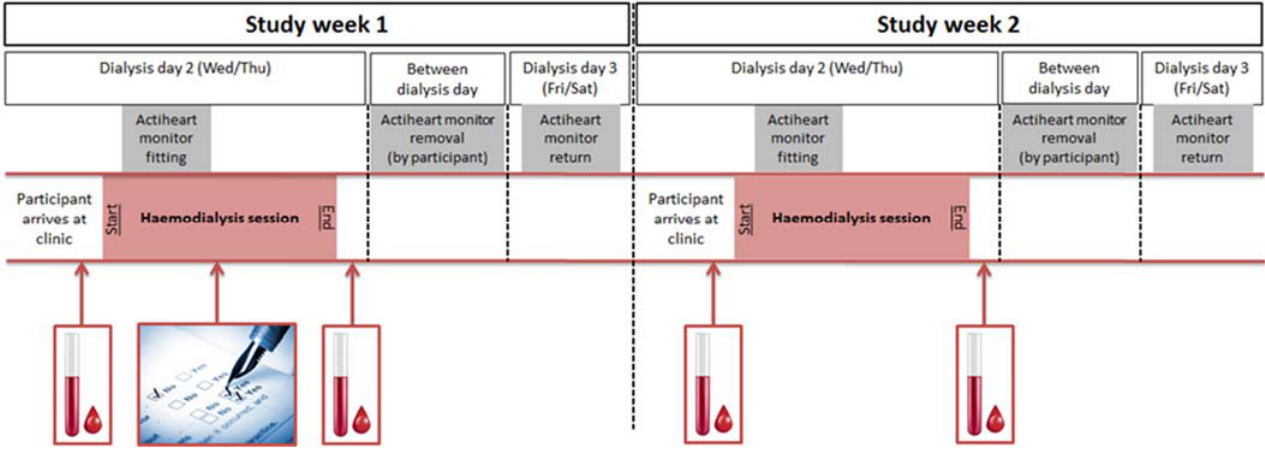
Figure A1. Outline of study days.